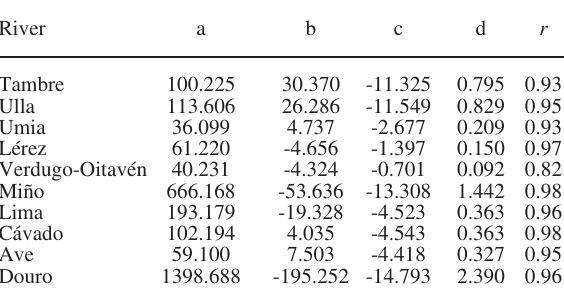
Table 2. – Coefficients of the weighted polynomial adjustment to monthly means corresponding to the equation Q = a + bm + cm 2 + dm 3 , where m is the month of the year expressed as m = 12 d /365, d is the day of the year running from 1 to 365 and Q is the runoff in m 3 s -1 . Note that months correspond to natural years instead of hydrologic years that start in October and end in September. The correlation coefficient r is also shown ( p <0.05).